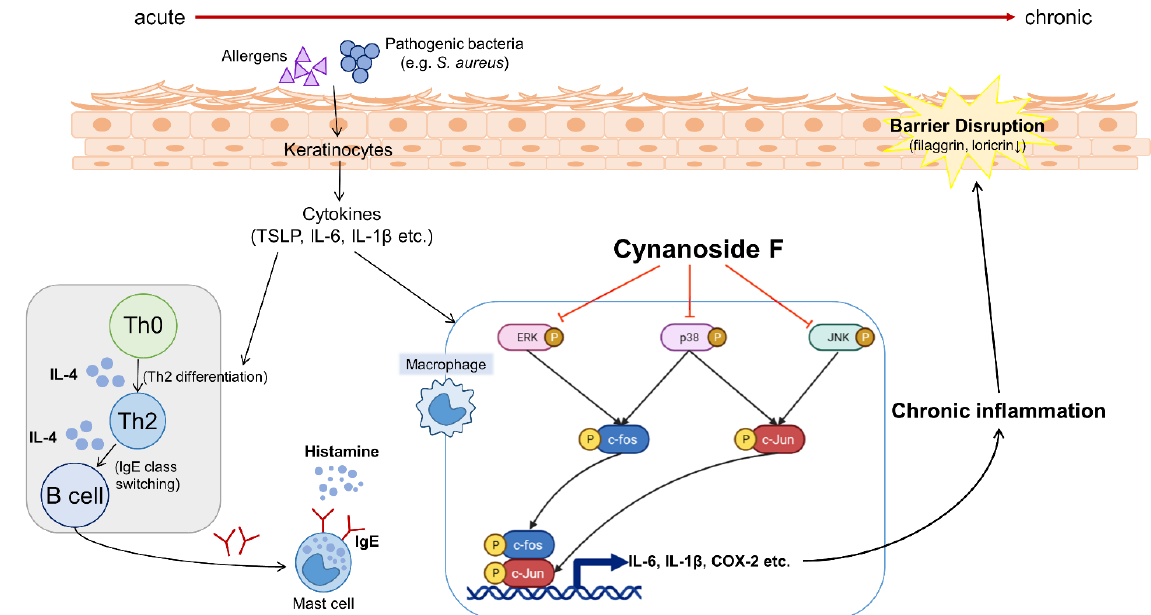
Figure 6. Schematic diagram of the effect of CF on the immunosuppression in AD. CF inhibits the MAPK/AP-1 signaling pathway, which in turn suppresses the expression of proinflammatory mediators in AD skin.